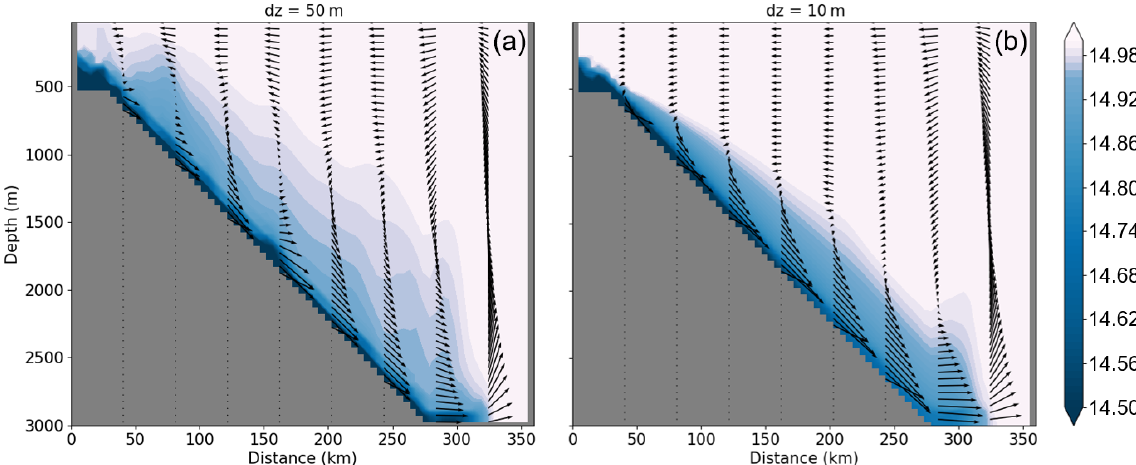
Figure 10. Idealized experiment simulating the rationale explored in Fig. 7 of Winton et al. (1998). Cold water (10 ◦ C) descends a shelf break in a configuration with ambient water at 15 ◦ C after 9d of simulation. Two vertical resolutions are used: (a) (cid:49)z = 50m, (b) (cid:49)z = 10m. Temperature ( ◦ C) is represented by colours. Vectors represent the velocity, with the vertical velocity being re-scaled according to the grid aspect ratio in the case in panel (a) .